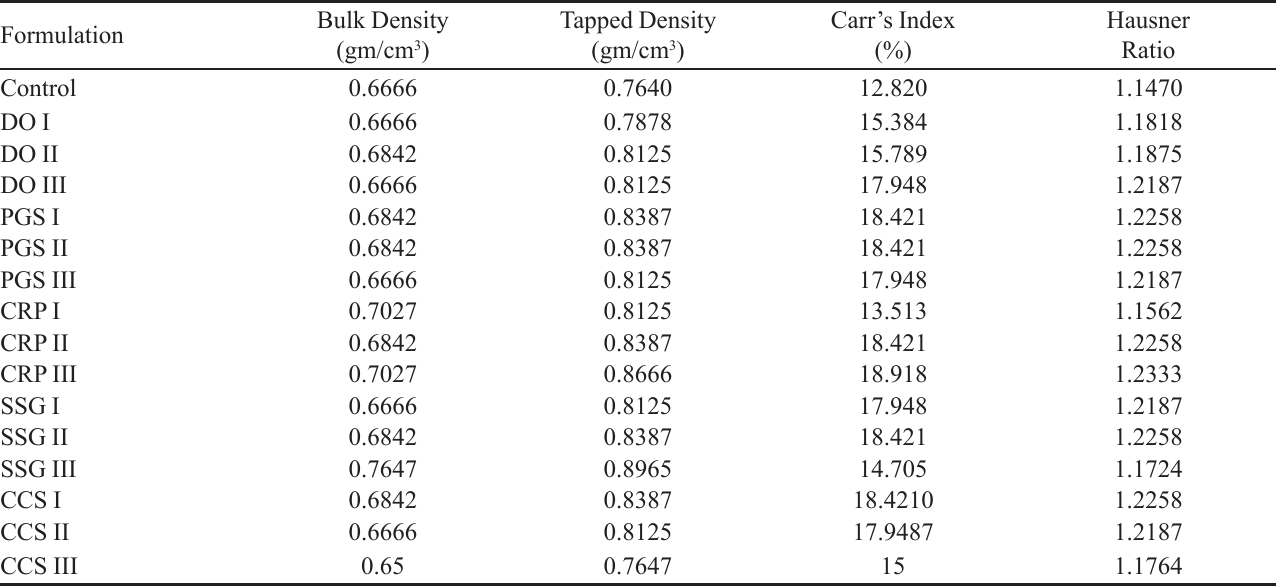
TABLE VI - Physical characterization of nifedipine blend Formulation